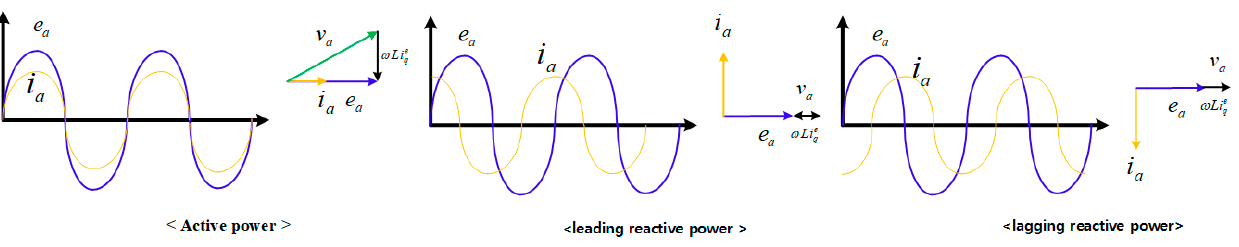
Figure 10. Three-phase grid voltage and current phasor diagram.